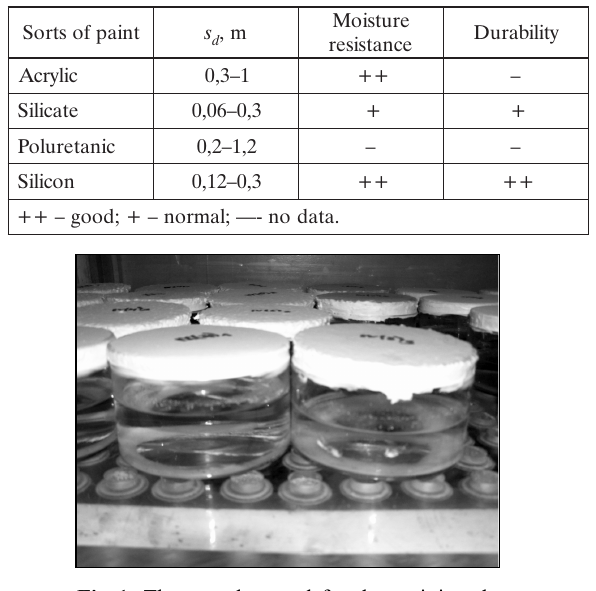
Fig 1. The samples used for determining the water vapour permeability in the paint-thin ren- dering